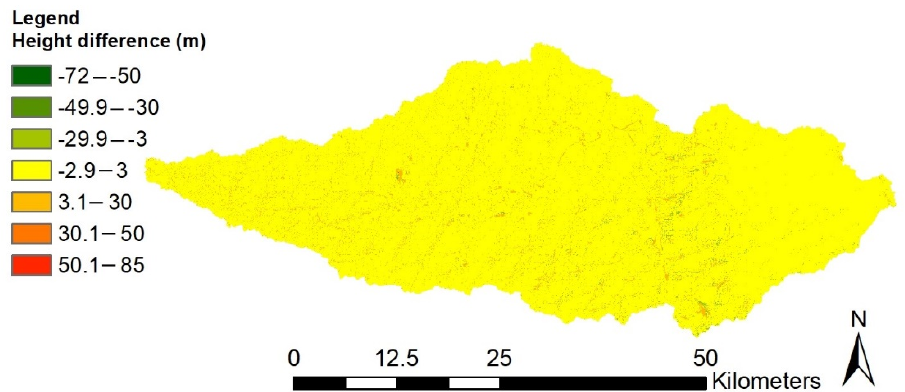
Figure 5. Map of the elevation difference between Alos Palsar DEM and SRTM 30 DEM.